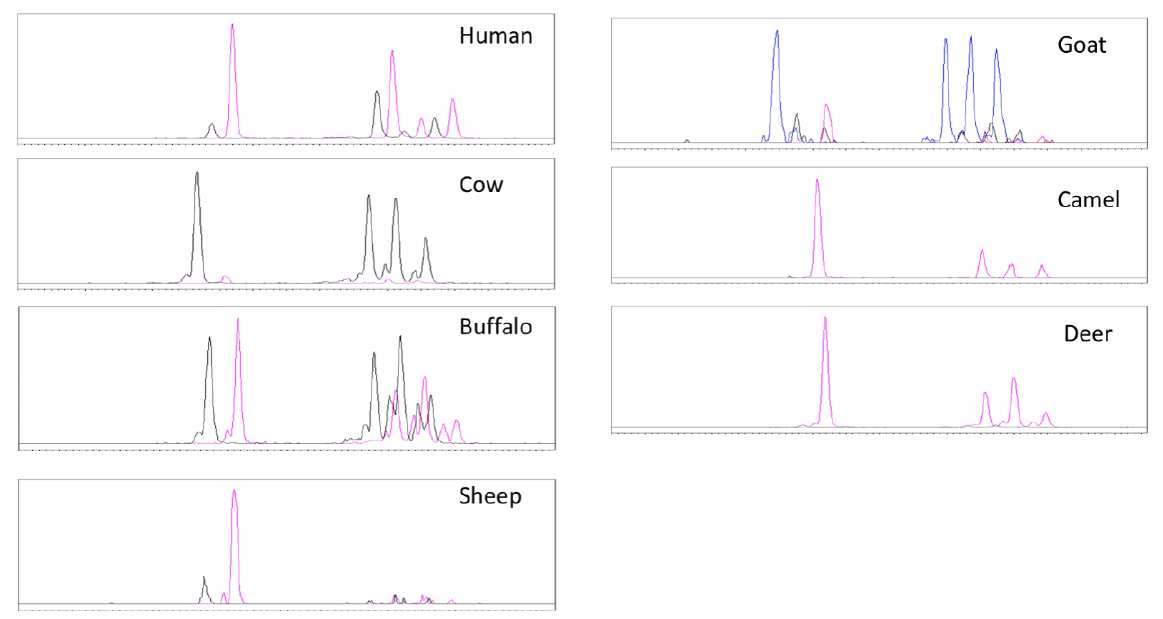
Figure 2. Gangliosides HPLC traces in samples studies. GD3—black, GM3—pink, N-glycolylneuraminic acid analogue of GD3—blue.